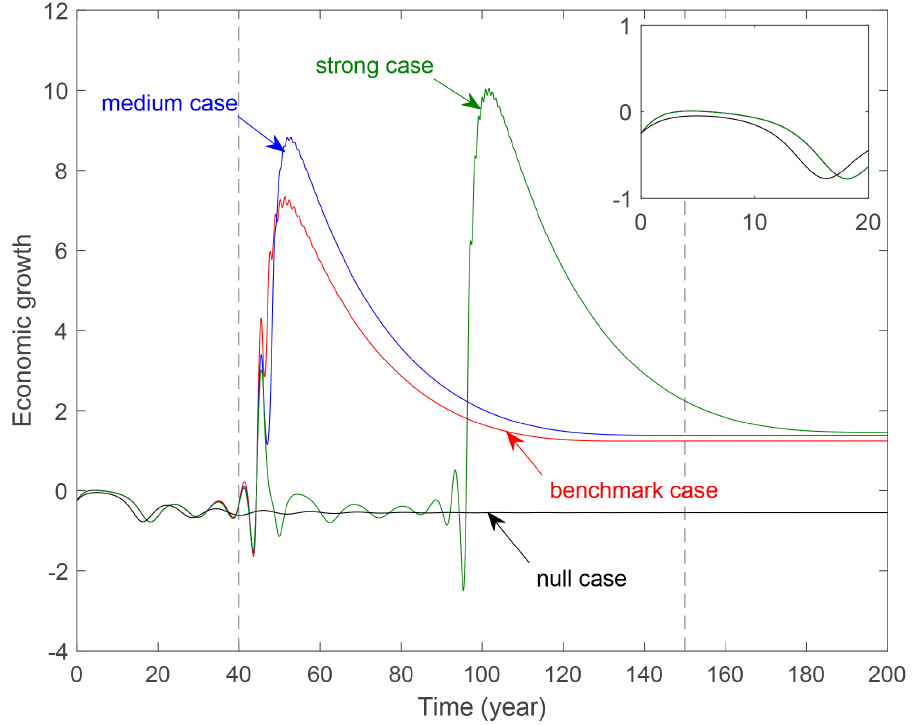
Fig 9. Evolution of economic growth with different consumers control parameter c 3 . Benchmark case : c 3 = 0.1037. Medium case : c 3 = 0.1437. Strong case : c 3 = 0.1637.